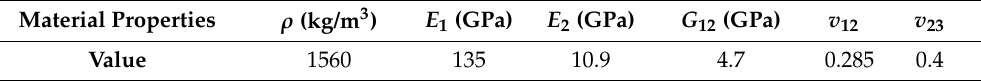
Figure 4. Schematic diagram of the composite plate with damage and transducers. Table 1. Material properties of a single ply of the composite plate.